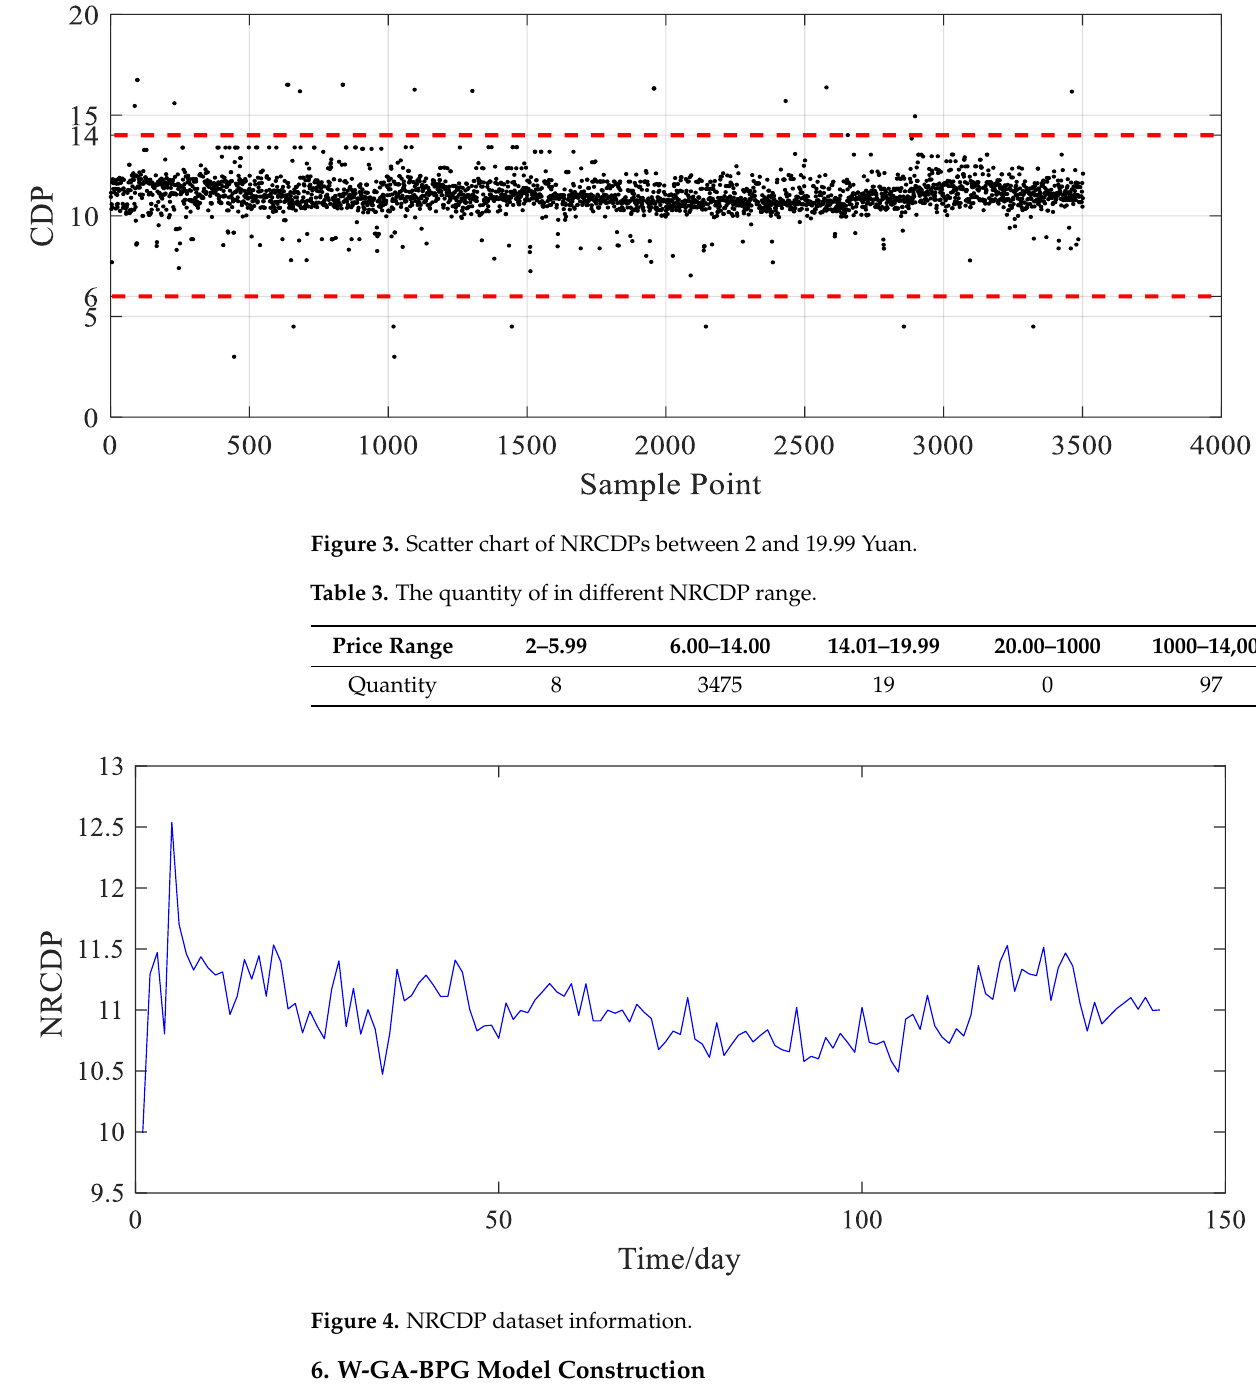
Figure 4. NRCDP dataset information.